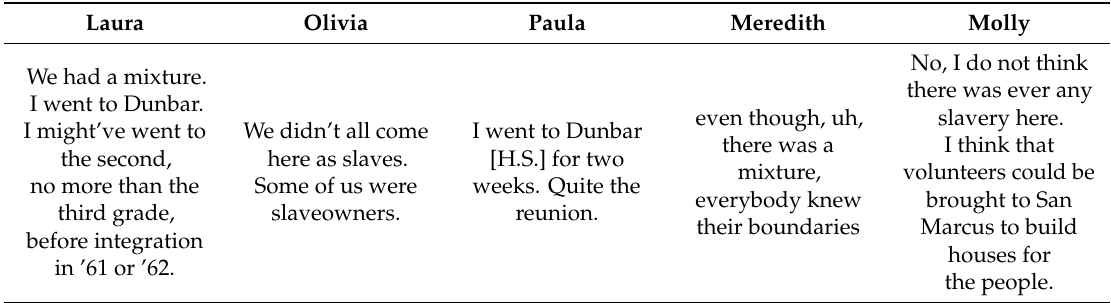
Table 2. Emergent Themes on History of Racism and